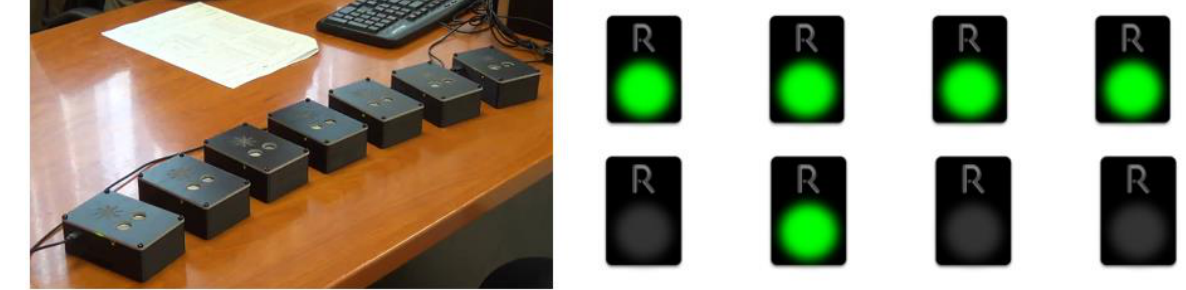
Figure 1. The R4Alz original version and the R4Alz-R (electronic form).